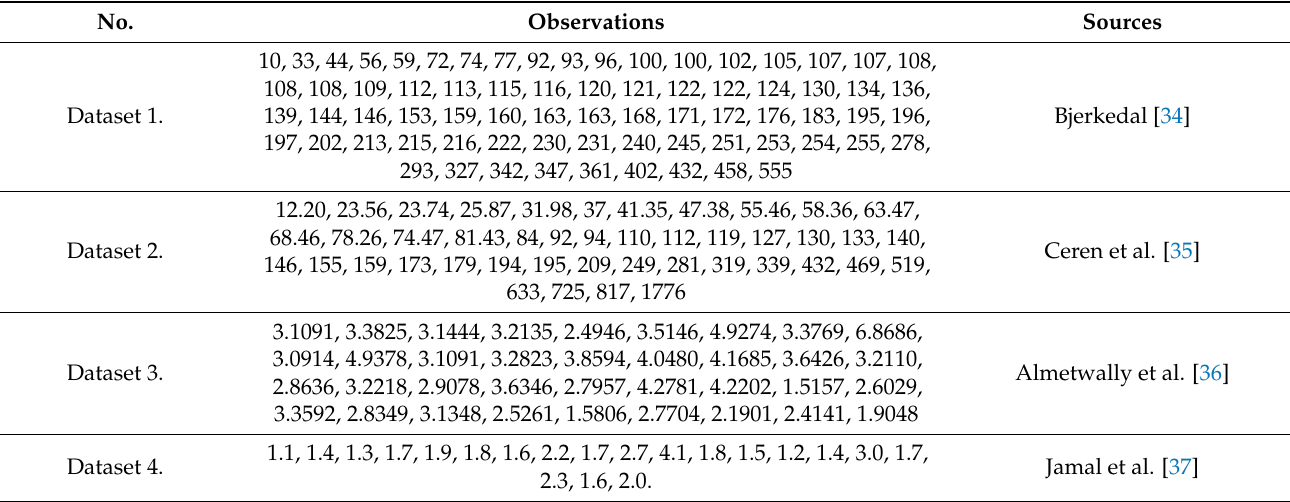
Table 5. Medical